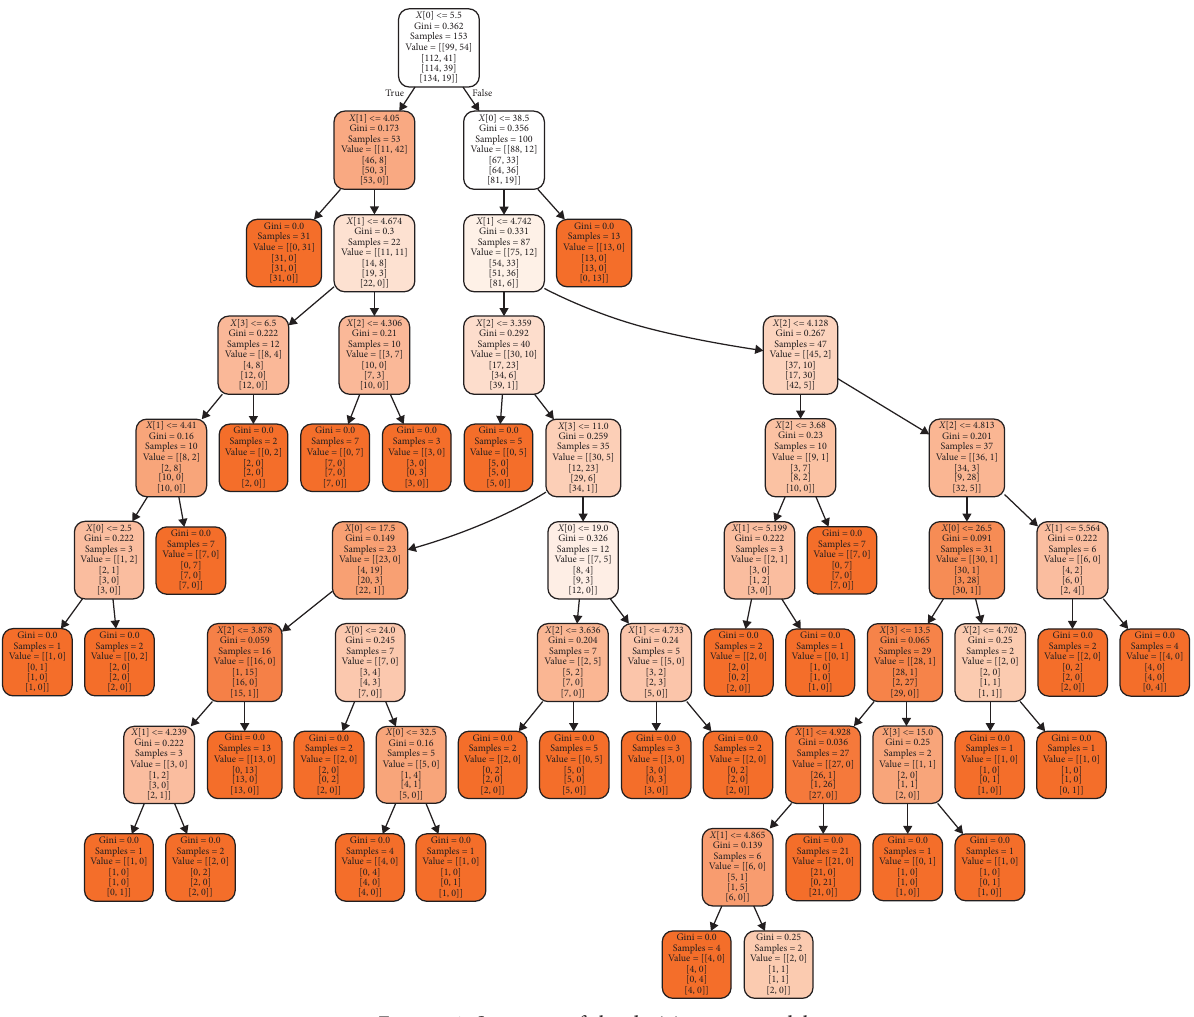
Figure 4: Structure of the decision tree model. Table 2: Predictive results of eight case histories.